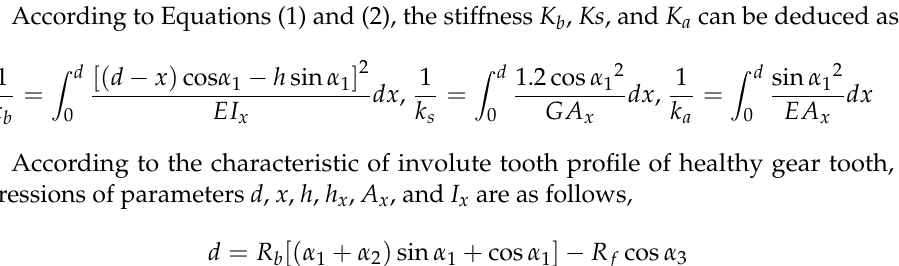
Figure 2. The cantilever beam model of gear with tooth surface crack fault. where k b , k s , and k a signify the bending stiffness, shear stiffness, and axial compressive stiffness, respectively. F refers to the meshing force acting on the gear tooth. E and G are the Young’s modulus and shear modulus, respectively, and it is assumed that the material